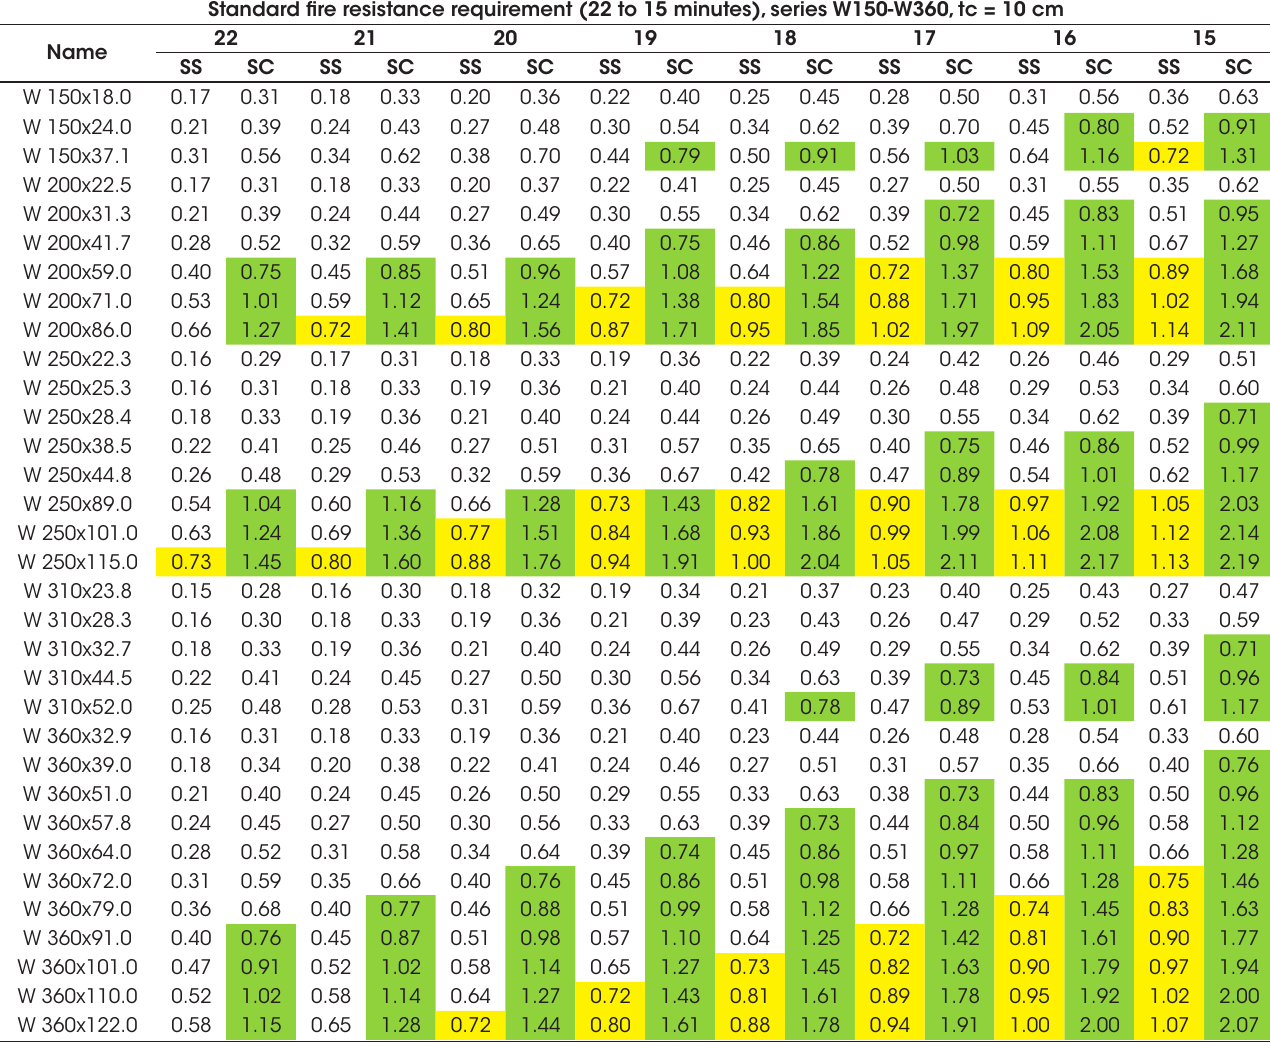
Load factors as function of the standard fire resistance requirement for composite beams with 10 cm slab and Gerdau profile series W150-W360